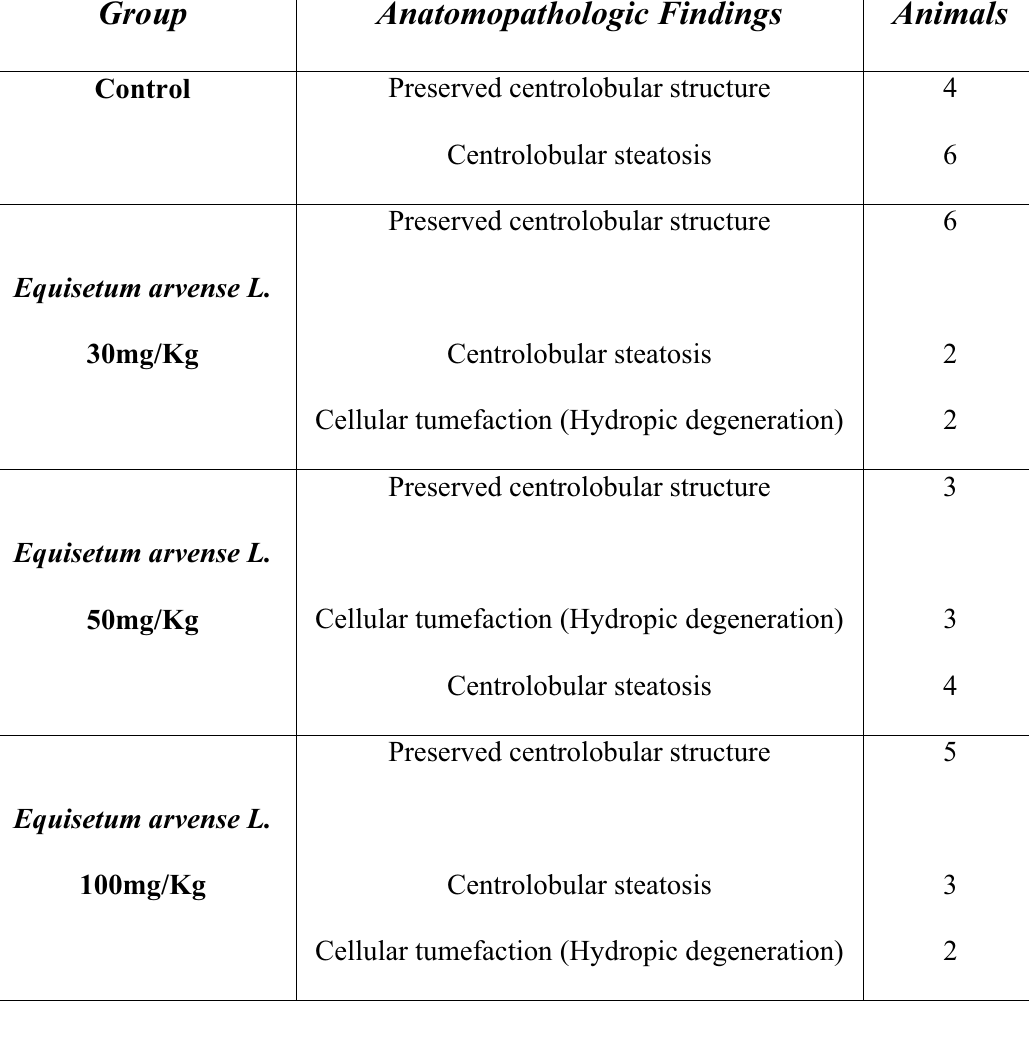
TABLE 2 - Effects of treatment with Control or graded doses of Equisetum arvense L. in the hepatic morphology